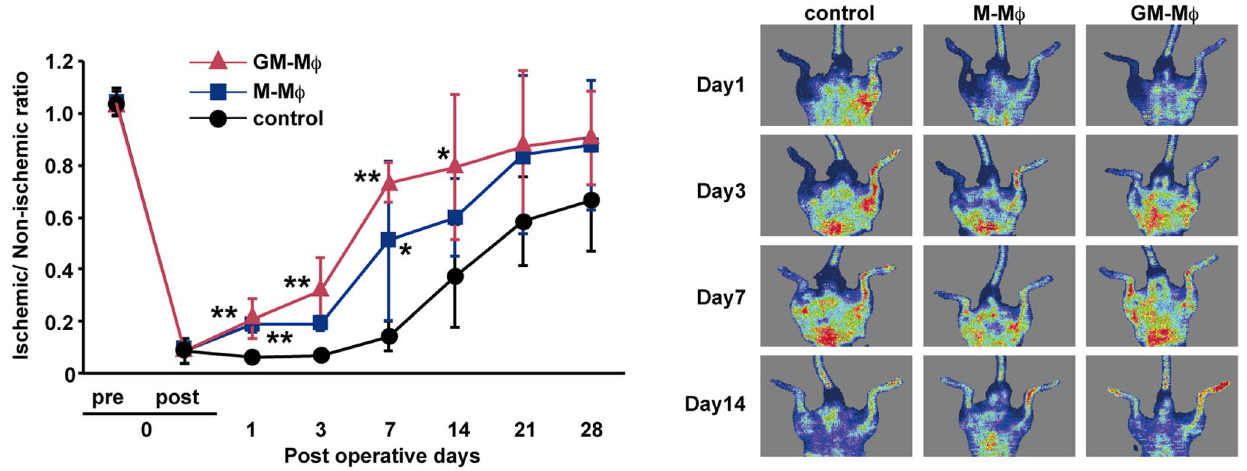
Figure 4. Recovery of blood flow in ischemic limbs treated with M-Mø and GM-Mø. Representative laser Doppler perfusion images were taken at indicated intervals for the PBS control group, M-Mø group, and GM-Mø group. Data are expressed as mean 6 SEM, n=5 group, ** P , 0.01,